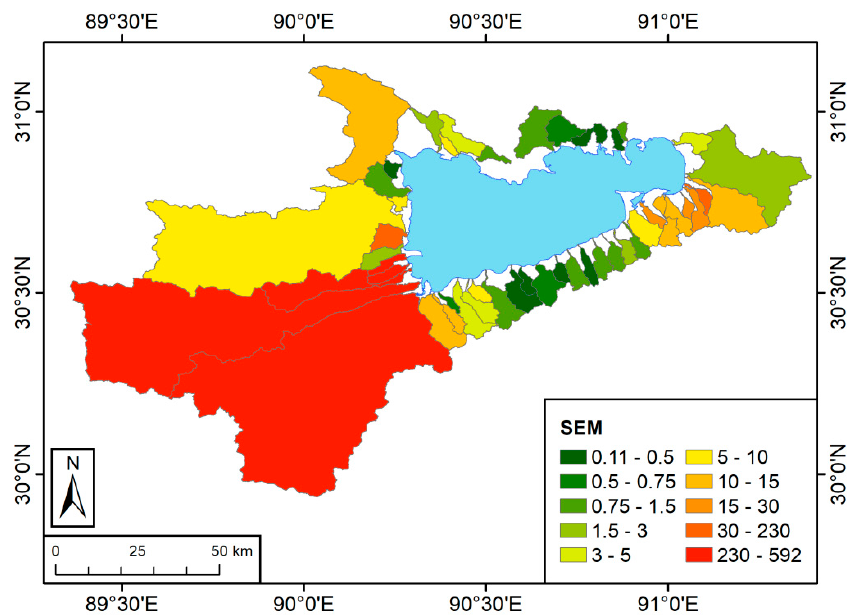
Figure 8. Standard error of the mean (SEM) of each subcatchment based on matched subcatchment areas across nine DEM datasets. The southwestern area has the highest SEM due to larger, more coarsely-delineated subcatchments that are paired up with finer TDX12 subcatchments. Unclassified, white areas bordering the lake are due in part to the selected minimum catchment size used to define a stream.